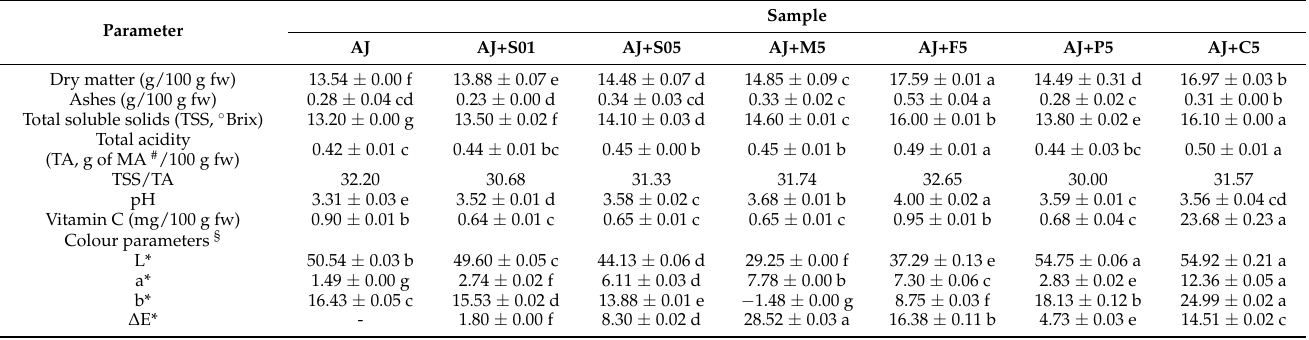
Table 1. Physico-chemical composition and colour parameters of apple juice and enriched apple smoothies.